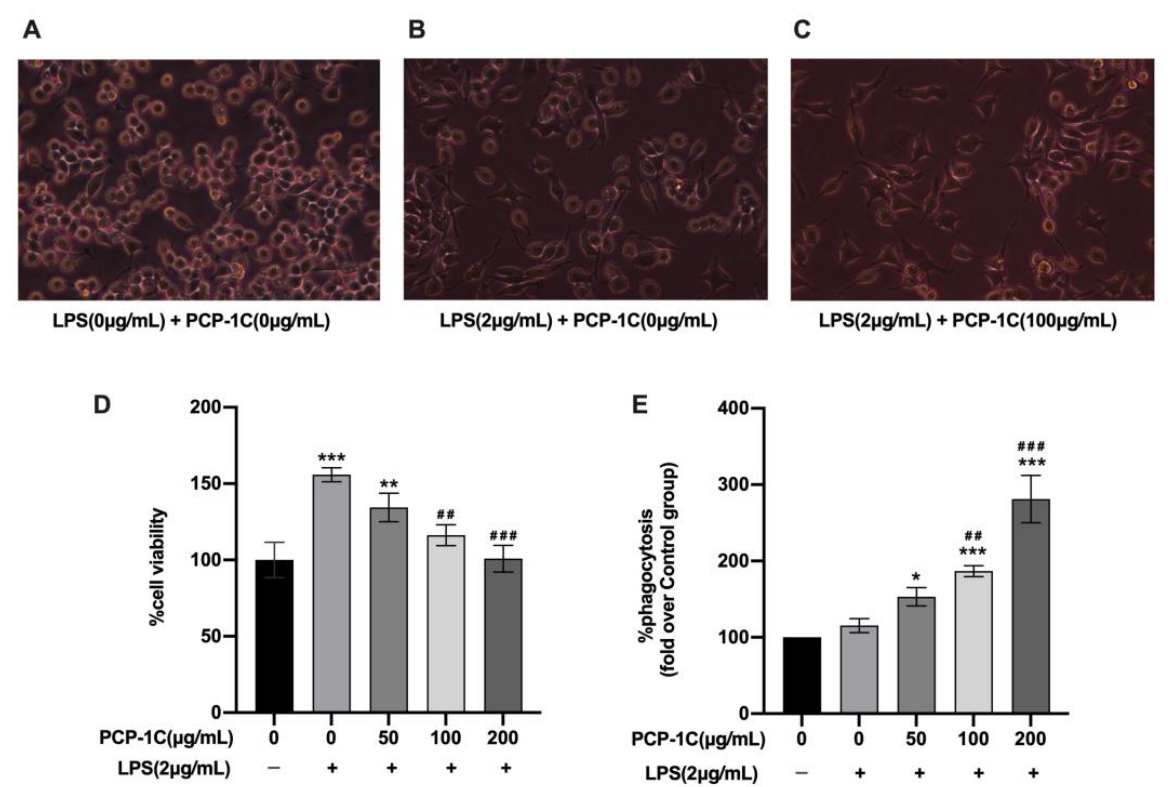
Figure 4. The morphology of RAW264.7 cells induced by PCP-1C and/or LPS: ( A ) macrophages cultured with blank medium; ( B ) macrophages induced by 2 µ g/mL LPS for 24 h; ( C ) macrophages stimulated by 100 µ g/mL PCP-1C and 2 µ g/mL LPS for 24 h; viability of macrophage ( D ); and the capability of macrophages to phagocytose neutral red ( E ) after stimulation with 50 µ g/mL, 100 µ g/mL, and 200 µ g/mL PCP-1C and/or 2 µ g/mL LPS for 24 h. Cell viability (%) = (OD value of the experimental group–OD value of the blank group) / (OD value of the control group–OD value of the blank group) × 100%. Phagocytic ability (%) = OD value of the experimental group/OD value of the blank group × 100%. * p < 0.05, ** p < 0.01, *** p < 0.001 vs. Control, ## p < 0.01, ### p < 0.001 vs. LPS; “+” indicates the cells were treated with LPS, while “−” indicates they were treated without LPS.